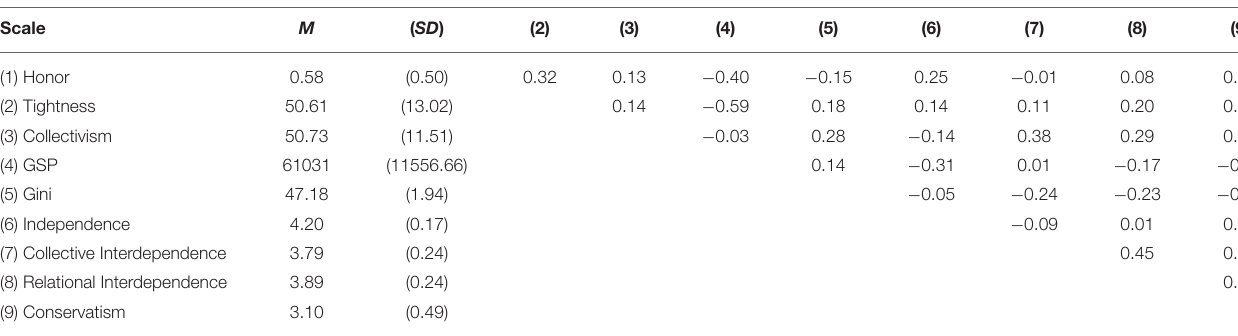
TABLE 2B | Correlation matrix and descriptive statistics for state-level variables.